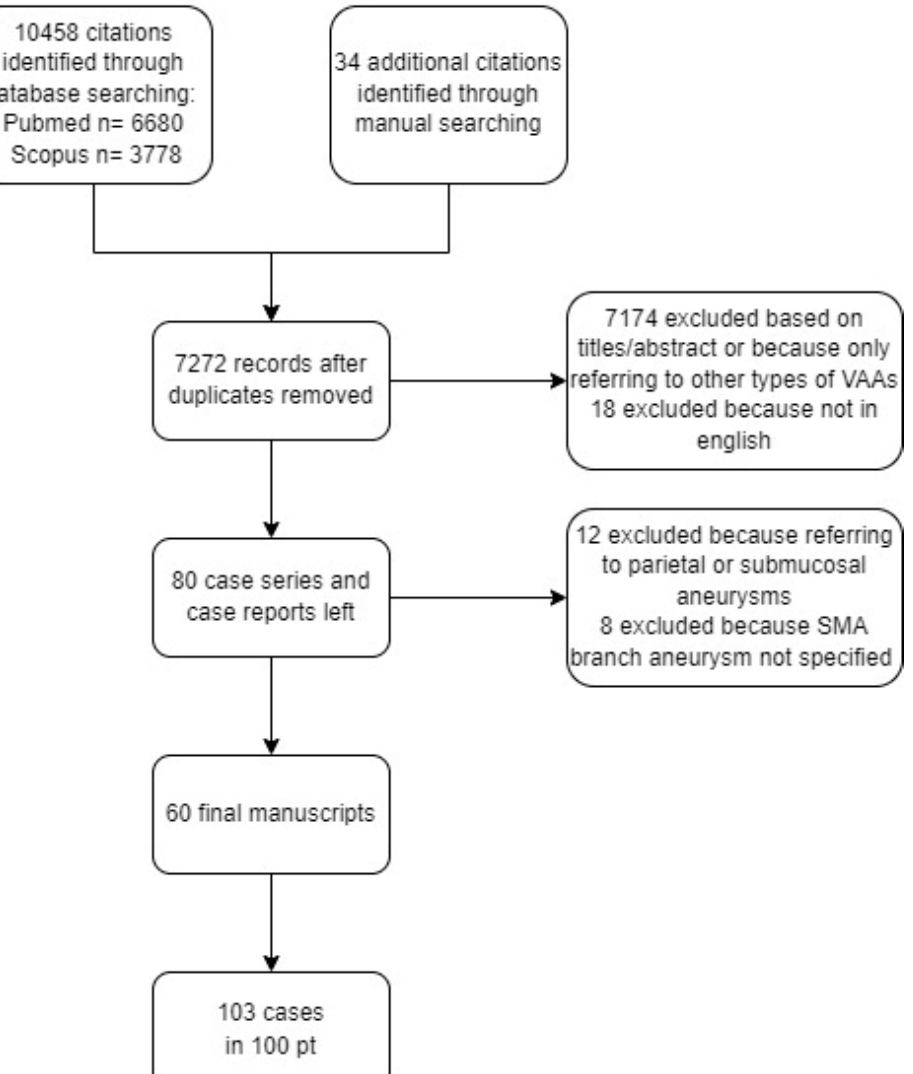
Figure 3. Transcatheter arterial embolization with coils of the pseudoaneurysm. ( A ) Angiogram af ‐ ter the first procedure showing complete occlusion of the 2nd JA (arrow). ( B ) Angiogram after the second procedure demonstrating complete occlusion of the distal branch of the 1st JA (arrow), with residual filling of the pseudoaneurysm trough the proximal branch.